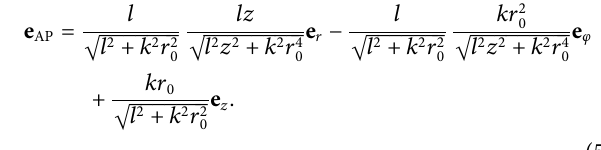
Frontiers in Physics |